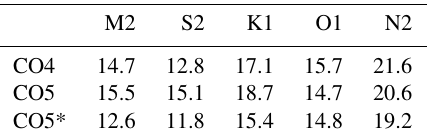
Table 5. Elevation RMSE of phase in degrees as compared to ob-